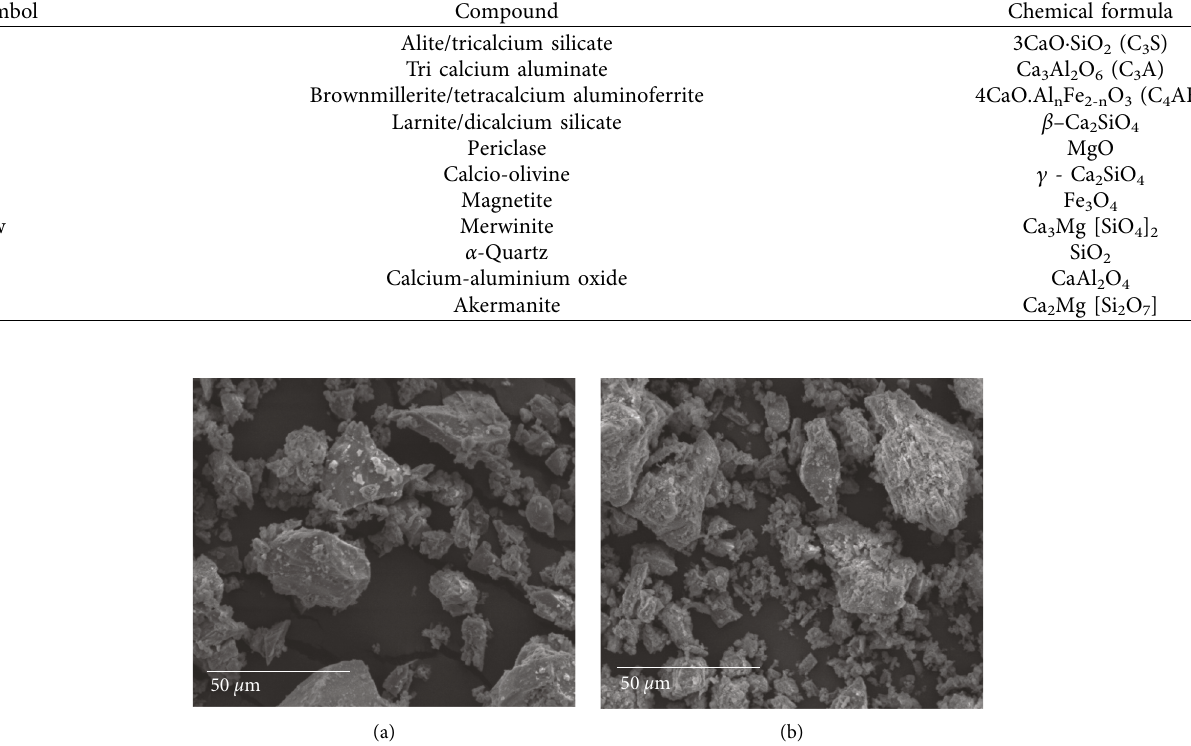
Table 3: Mineralogical phases present in CEM-I and LFS with a chemical formula.